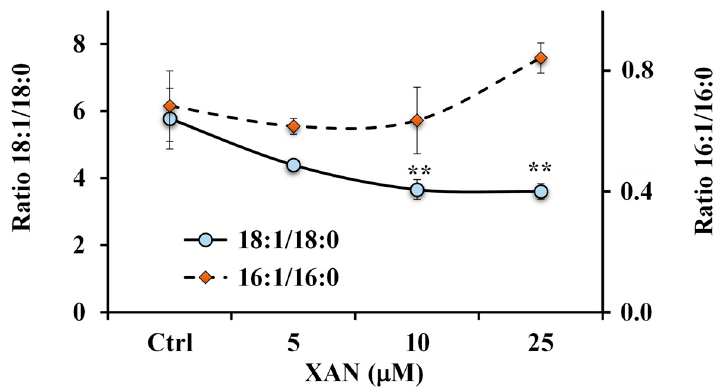
Figure 8. Values of the ratios 18:1 n-9/18:0 and 16:1 n-7/16:0 measured in control HeLa cells and cells treated for 24 h with different amounts (5, 10 and 25 μ M) of xanthomicrol (XAN). ** = p < 0.01 versus Ctrl. Statistical significance of differences was assessed by One-way ANOVA and Bonferroni post Test.